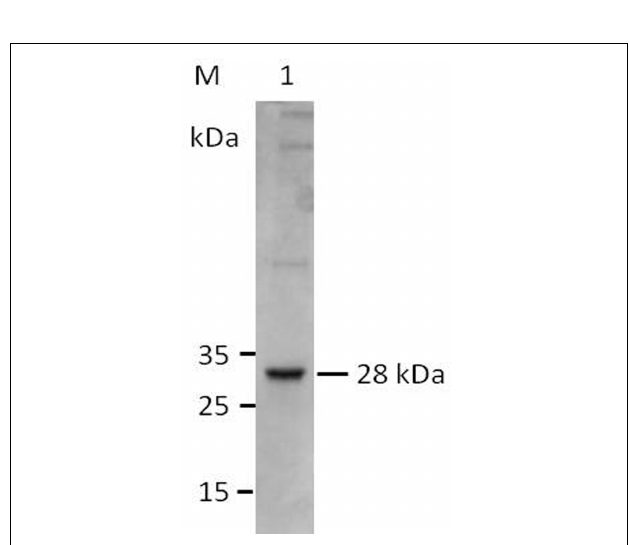
FIGURE 2 | Expression and purification of recombinant BmTPx-2 protein. M, PageRuler prestained protein ladder; 1, rBmTPx-2 was expressed in Escherichia coli BL21 and purified with Ni-NTA agarose beads. Purified rBmTPx-2-His was approximately 28 kDa and was used in subsequent antibody production and antioxidant activity